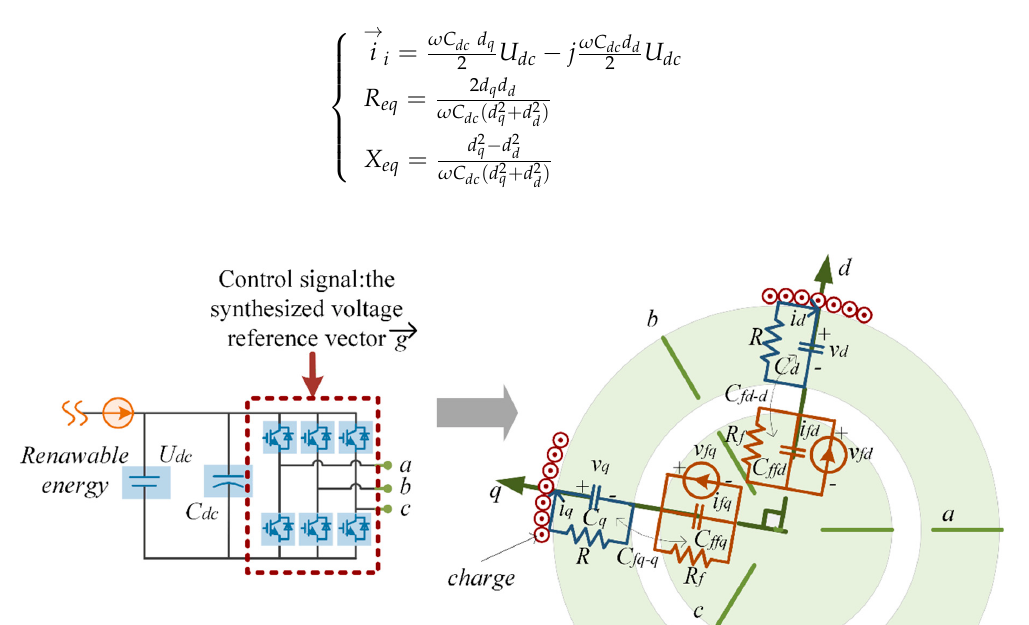
Figure 3. Representation of the electrostatic machine.